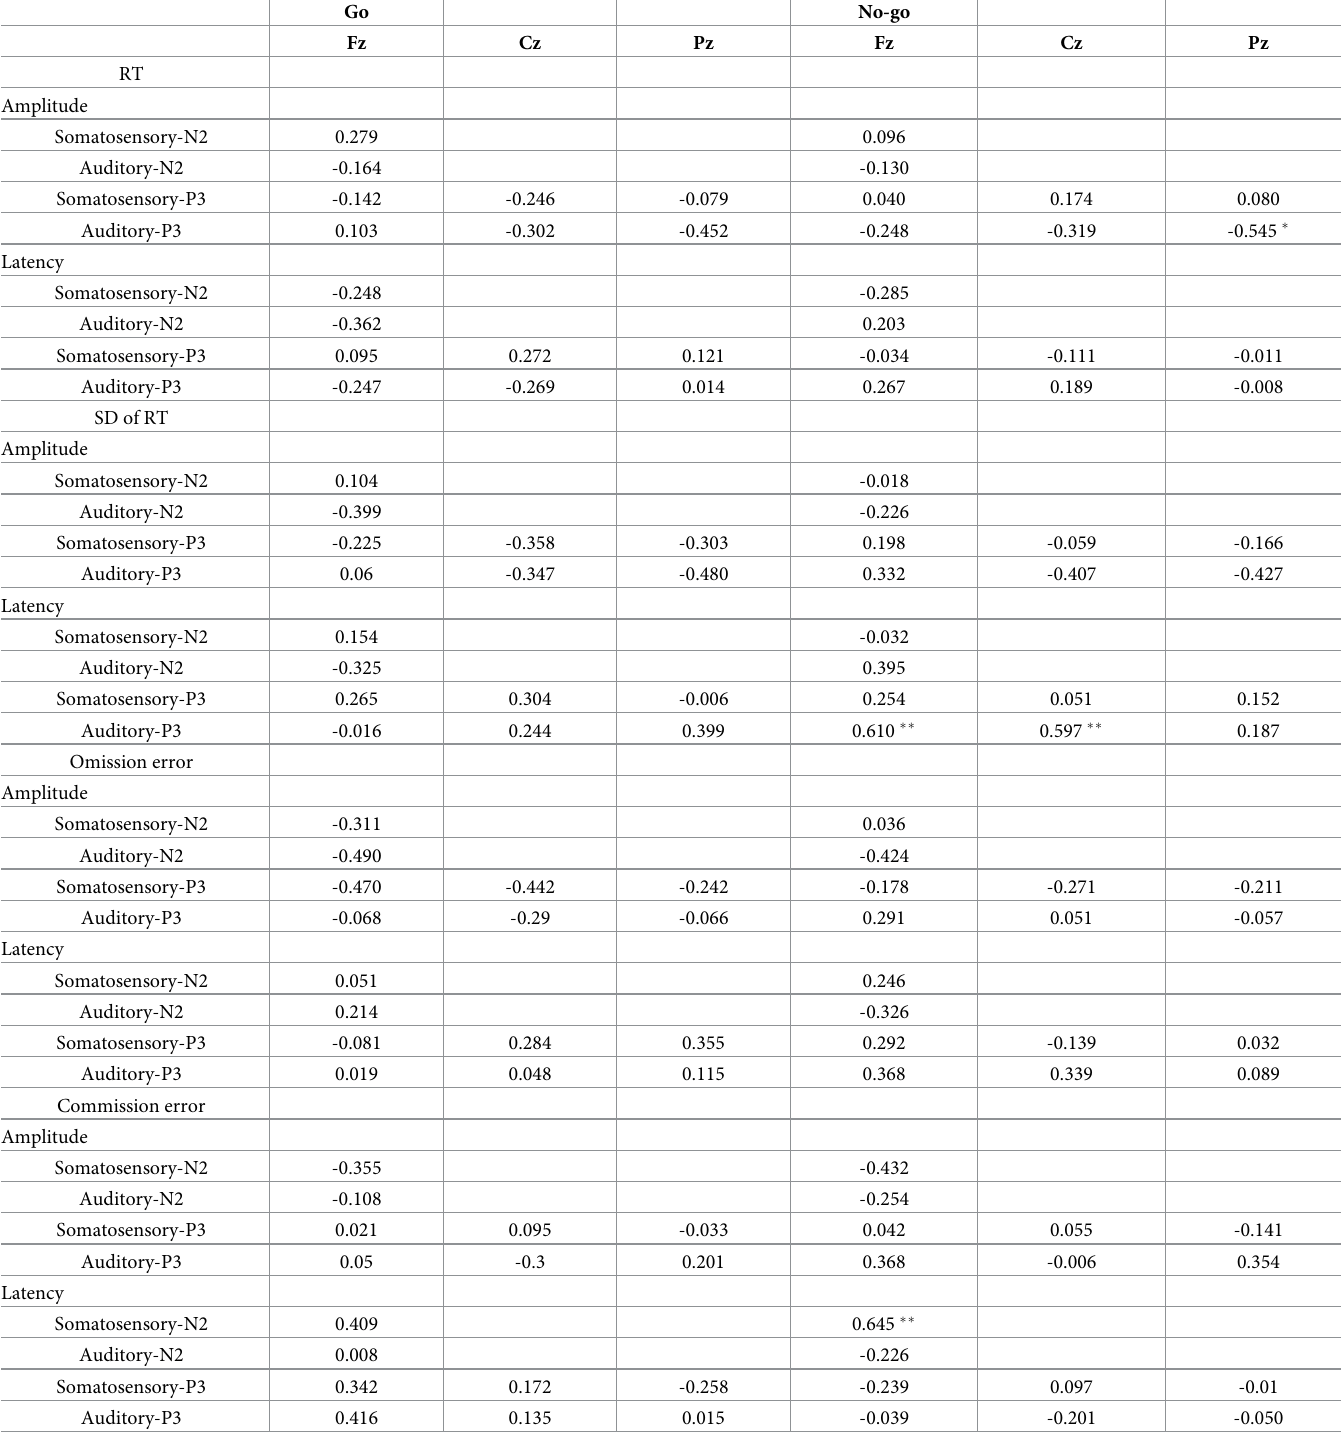
Table 4. Correlation matrix between behavioral data and amplitude and latency of ERP